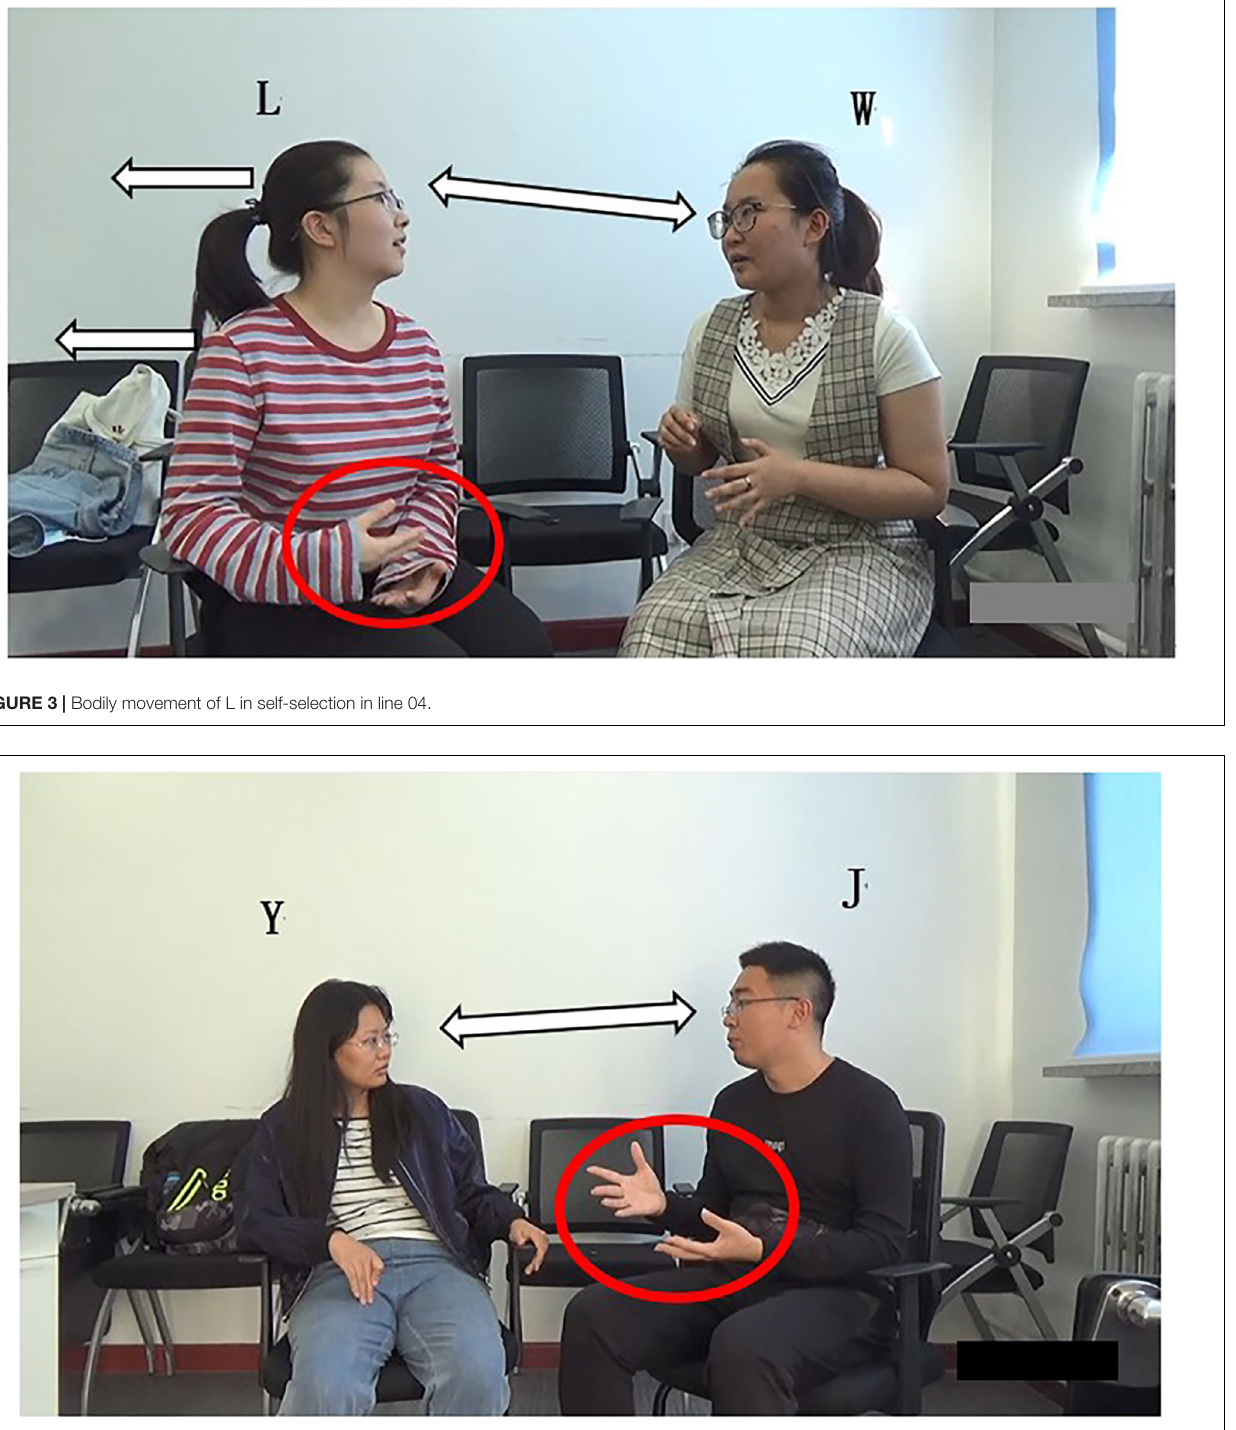
FIGURE 4 | Bodily movements of Y and J in lines